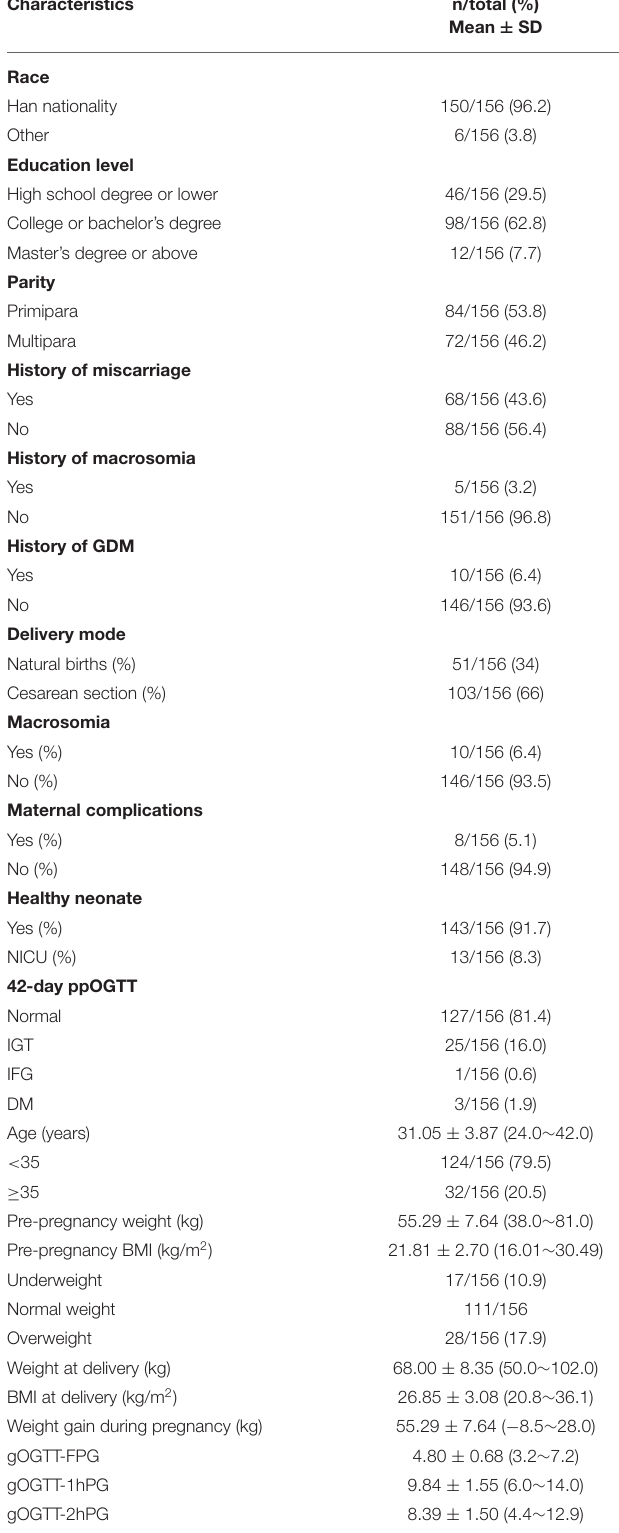
TABLE 1 | General characteristics, maternal and newborn outcomes of the participants ( n = 156).